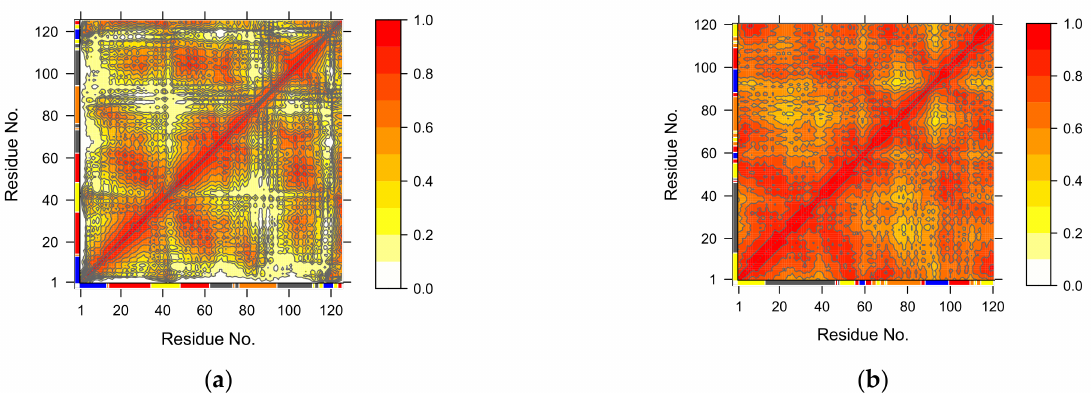
Figure 9. Visualization of the results obtained from the GeoStaS atomic movement similarity matrix (AMSM). AgamOBP1 domain assignment (panel a ); AaegOBP22 domain assignment (panel b ). The colour bars at the x and y axes depict the residues assigned to the different domains that were found. The colour scale is the same in both matrices: red indicates strong correlations, and white strong